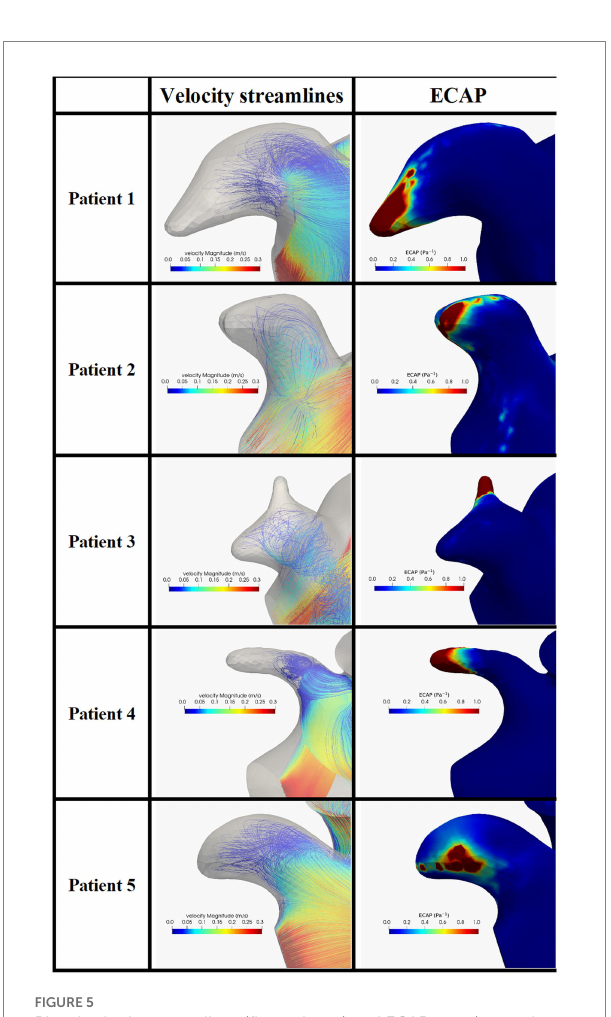
FIGURE 5 Blood velocity streamlines (first column) and ECAP map